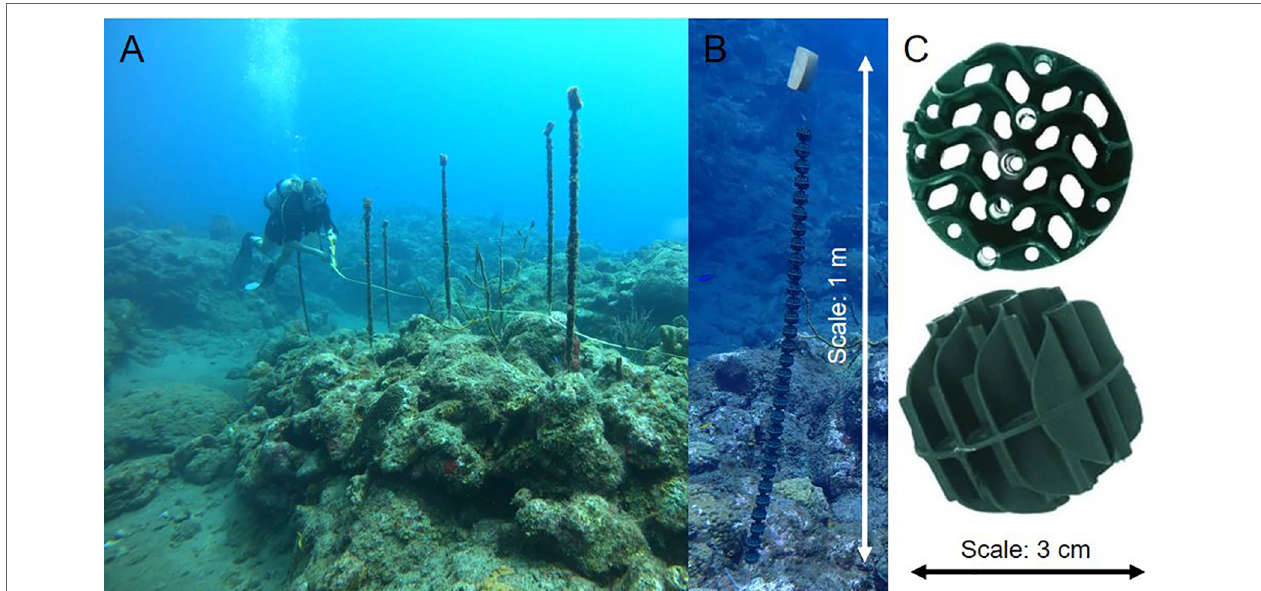
FIGURE 2 | (A) Patch reef (no. 4) with streamers on which the transect tape is removed after monitoring. (B) Streamer with buoy and (C) Close-up of bio